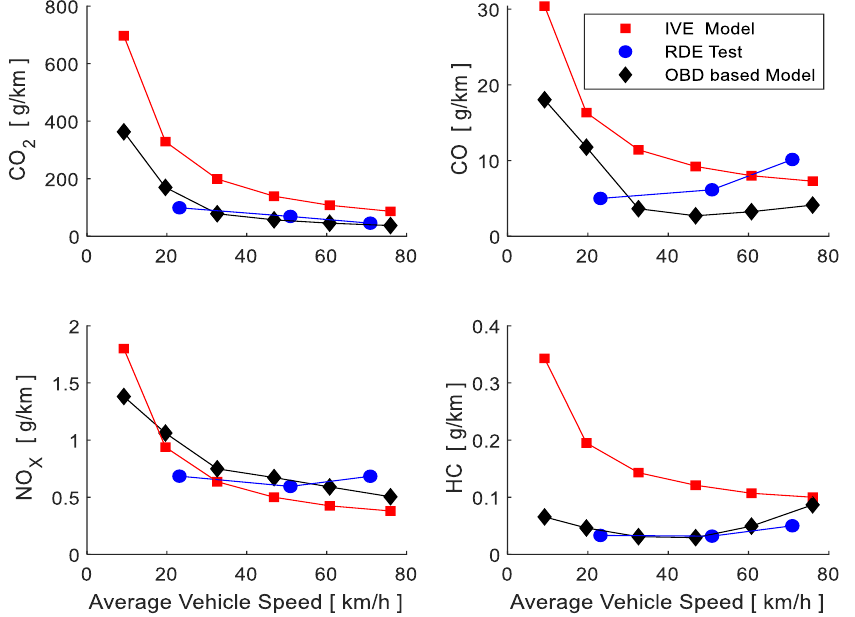
Figure 11. Emission factors according to average driving speed for the IVE model, RDE test and OBDM.